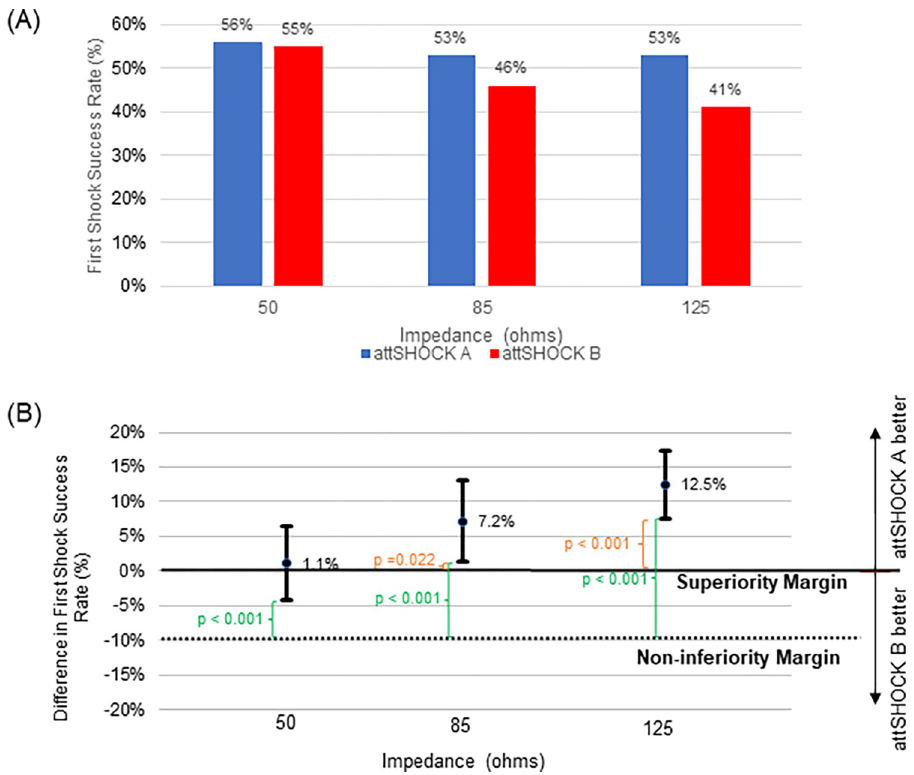
Fig 11. Animal Study #2 results. (A) Observed first shock success rates for termination of ventricular fibrillation with attSHOCK A (blue) and attSHOCK B (red) at 50, 85 and 125 ohm impedances. (B) Difference in observed first shock success rates (attSHOCK A–attSHOCK B). At each of the three impedance levels, the mean difference (dot) and the 95% confidence interval of the difference (whiskers) in first shock success rates is shown. attSHOCK A was non- inferior to attSHOCK B as the entire 95% confidence interval of the difference (attSHOCK A–attSHOCK B) in first shock success rates was above the -10% prespecified non-inferiority margin (dotted line). At 85 and 125 ohms, the first shock success rate of attSHOCK A was superior to attSHOCK B as the entire 95% confidence interval of the difference in first shock success rates was above 0%. See text for details.